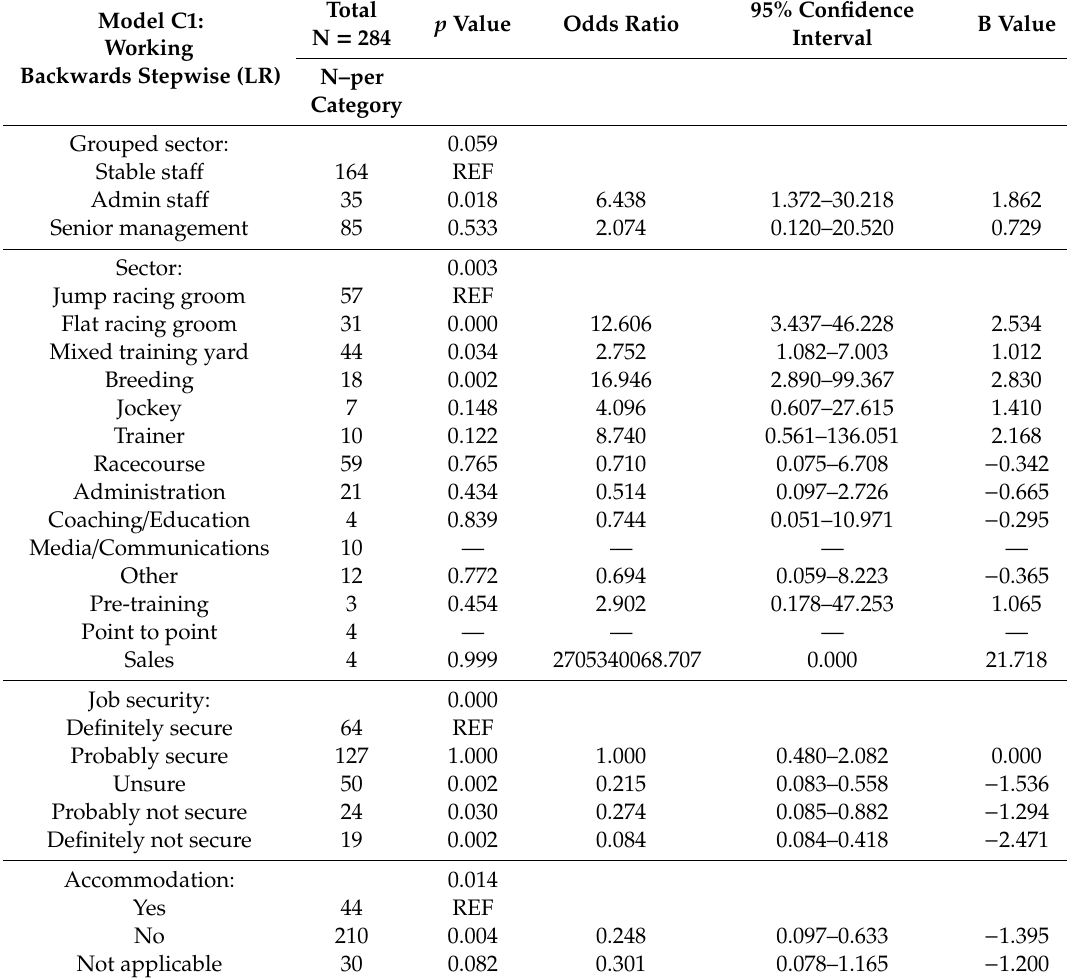
Table 3. Final BLR multivariate model (C1).